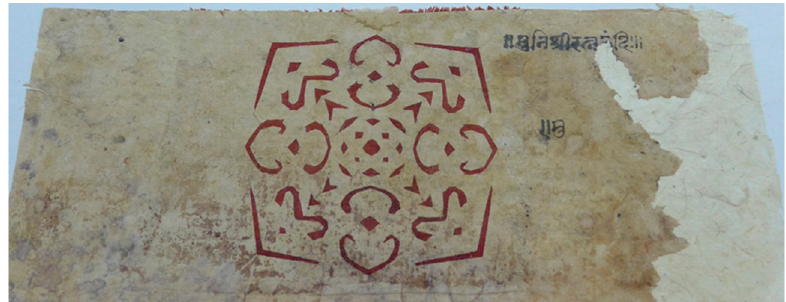
Figure 5. Dhammaparikkh ā by Hari ṣ e ṇ a, Jain Vidy ā Sa ṃ sth ā n n. 478. 41